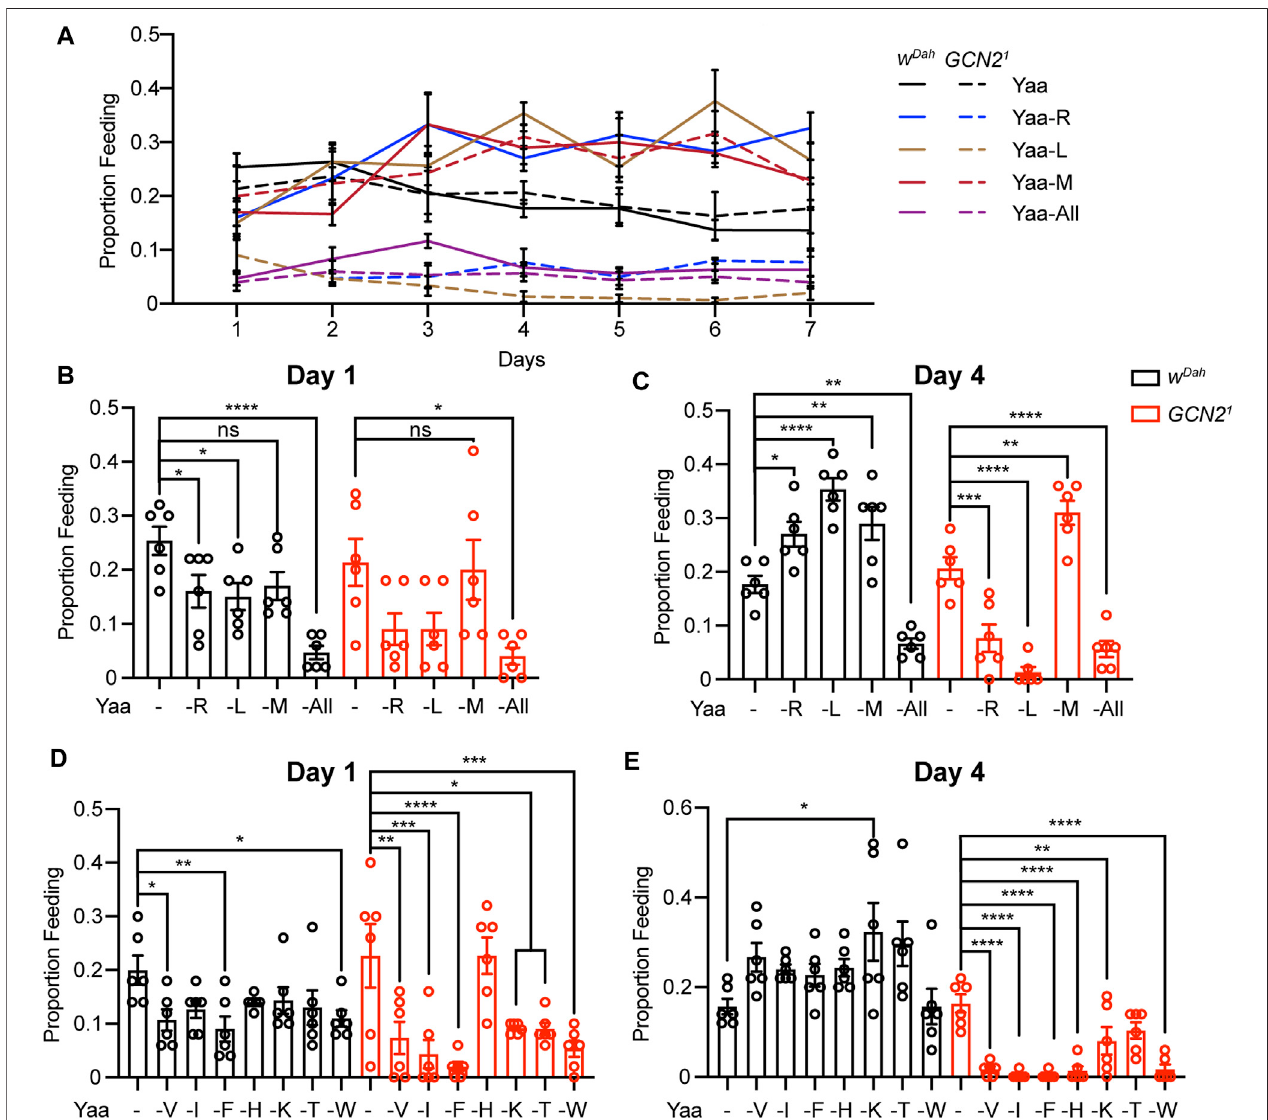
FIGURE 3 | GCN2 regulates feeding behaviour under long-term but not short-term deprivation of individual EAA. (A – C) Feeding rates measured by proboscis extension assay of w Dah control and Gcn2 1 mutant females over a period of 7 days on Yaa, -L, -R, -M, and -All diets (A) . Feeding rates of w Dah controls and Gcn2 1 mutants on day 1 (B) and day 4 (C) . (D,E) Feeding rates of w Dah controls and Gcn2 1 mutants on V, I, F, H, K, T, and W deprived diets on day 1 (D) and day 4 (E) . n = 6 vialswith fi ve fl iespervial.Dataarepresentasmean±s.e.m.One-wayANOVAfollowedbyDunnett ’ smultiplecomparisonstest, p valueswereadjustedformultiple